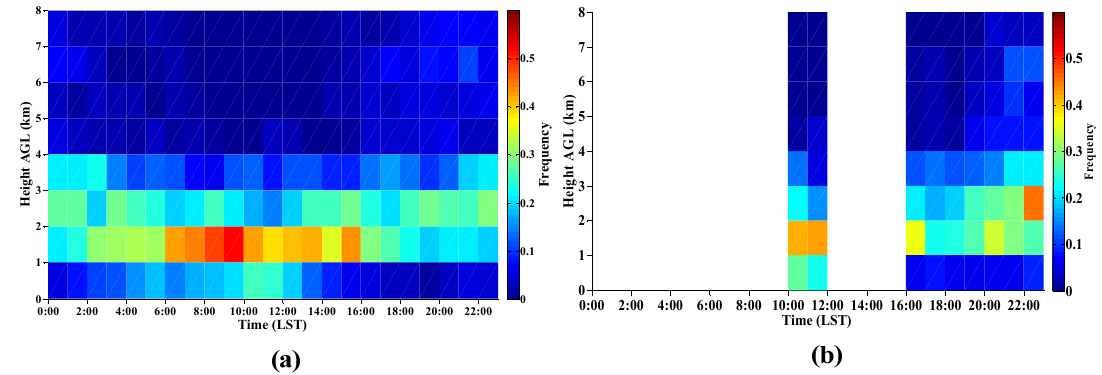
Figure 13. Averaged diurnal variation of CBH temporal distribution measured by: ( a ) CL31; and ( b ) WACAL during measurement period.